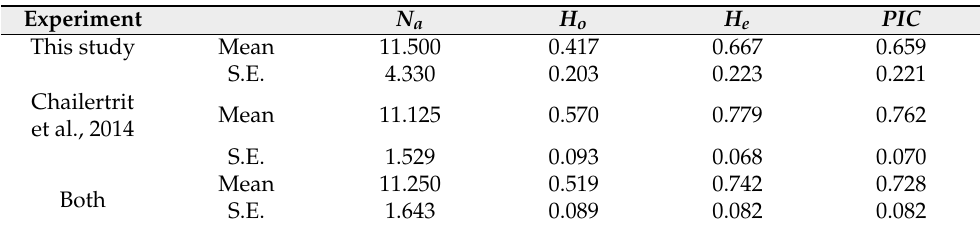
(Table 4). Marker-level descriptive statistics are presented in detail in Table S7. Table 4. Descriptive statistics for microsatellite markers based on 21 Siamese fighting fish ( Betta splendens , Regan, 1910) [2]. Experiment N a H o H e PIC This study Mean 11.500 0.417